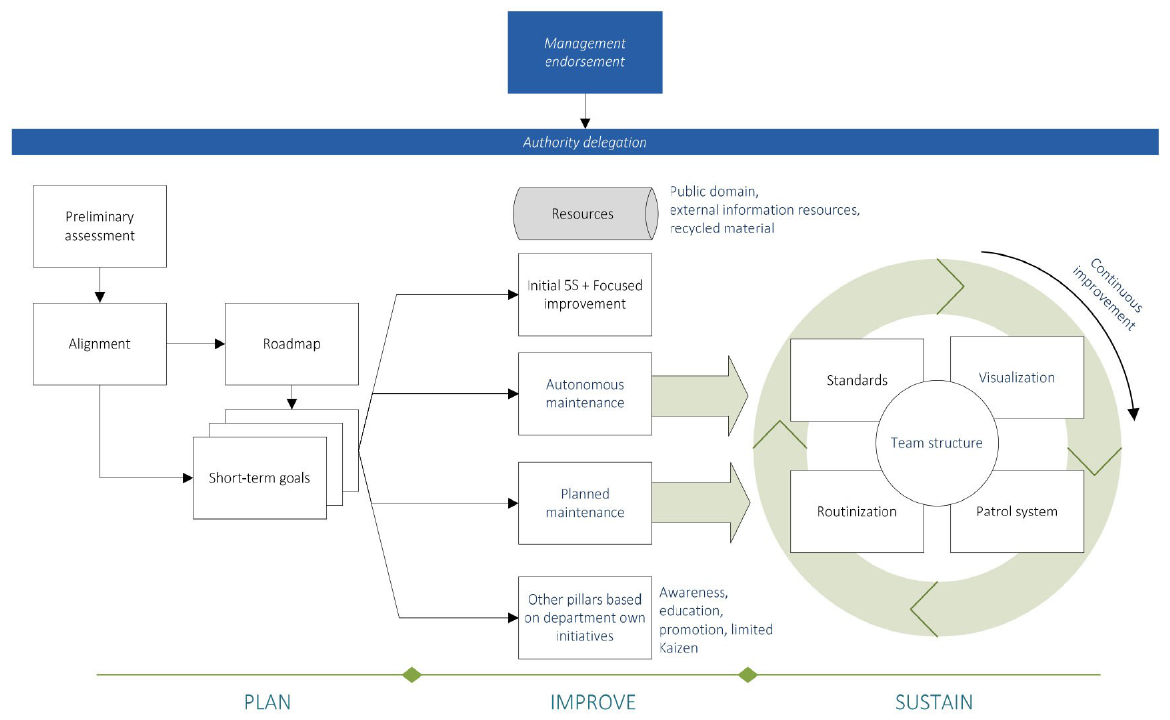
Figure 2. TPM implementation model in